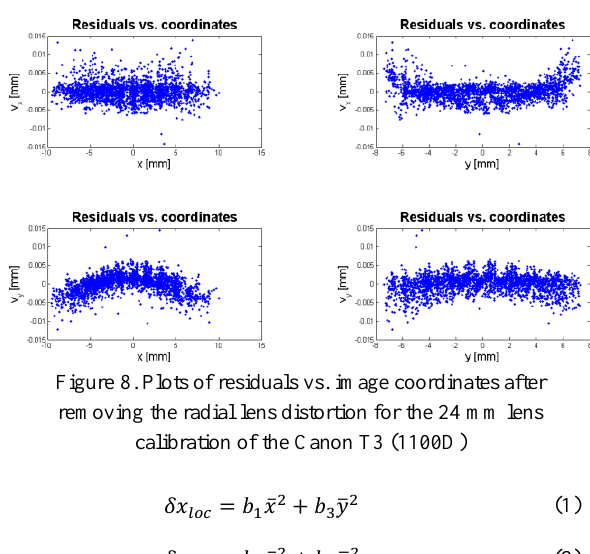
Figure 8. Plots of residuals vs. image coordinates after removing the radial lens distortion for the 24 mm lens calibration of the Canon T3